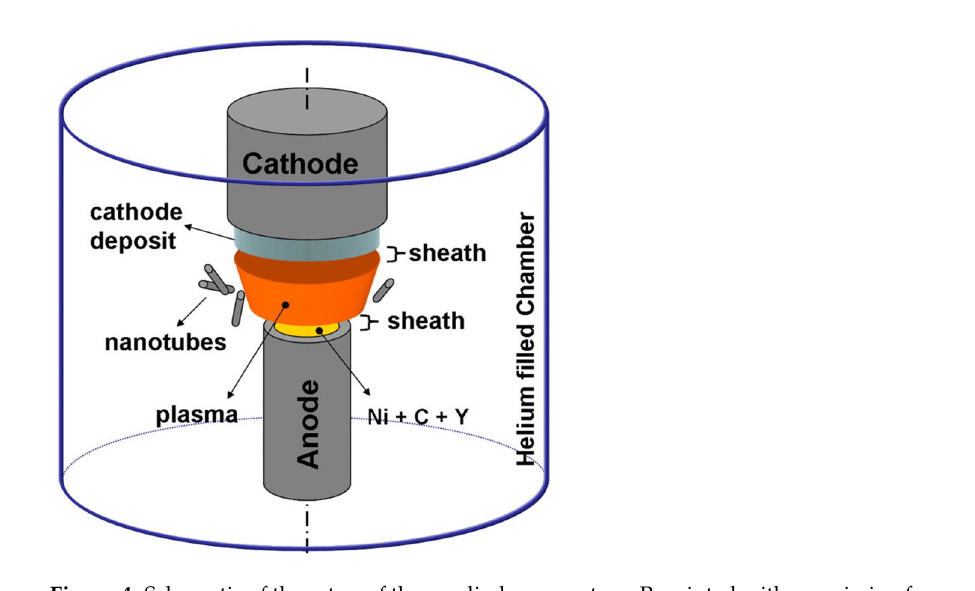
Figure 4. Schematic of the setup of the arc discharge system. Reprinted with permission from Ref. [76]. Copyright 2012, AIP Publishing.